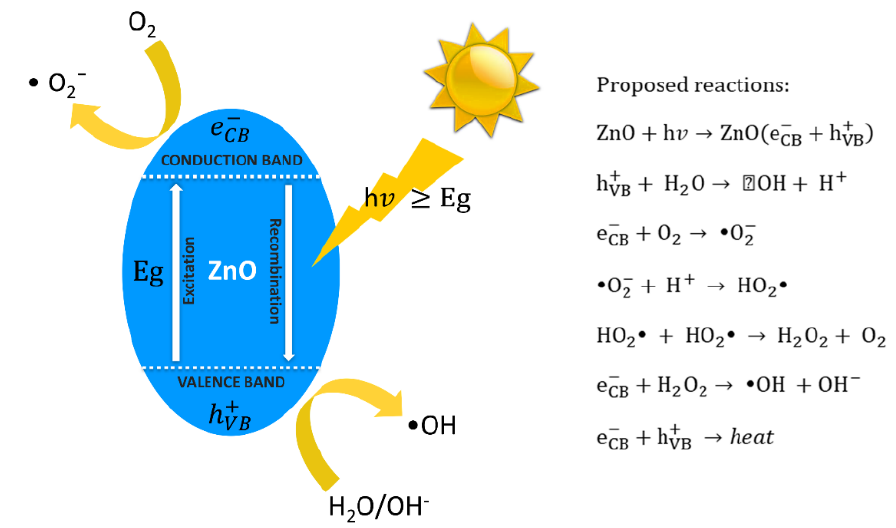
Figure 2. Schematic presentation of ZnO’s photocatalytic mechanism.